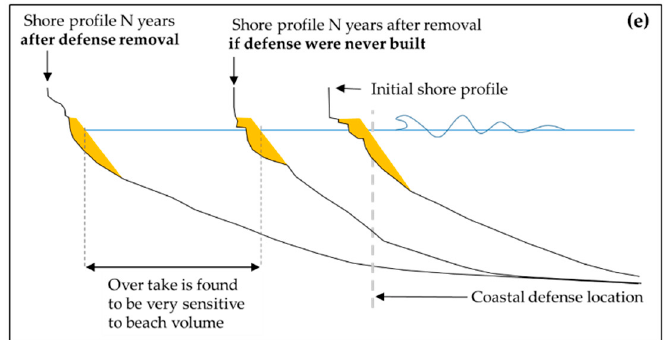
Figure 1. Illustration of the development and loss of a step in the shore platform profile due to the construction and removal of a vertical coast protection. Beach volume is represented as a yellow polygon and shore platform profile as a black solid line. The panels show an idealized beach and shore platform evolution; ( a ) initial beach and shore platform profile at the time of construction of the coastal defence; ( b ) after the construction of the defence, shore platform lowering (red arrows) seaward of the defence is larger than behind, and so a step develops; ( c ) when the defence is removed, the (steepened) shore platform previously behind the step is exposed to higher wave energy, inducing rapid shore platform and cliff retreat (the shore platform in front of the structure continues to erode at a low rate); ( d ) after a period of time the step is removed and a new quasi-equilibrium coupled beach and shore platform profile is reached; retreat rates then reduce and become more steady; ( e ) sensitivity analysis has shown that the ‘overtake’ (i.e., excess net shoreline retreat caused by this process) increases if beach volume decreases.